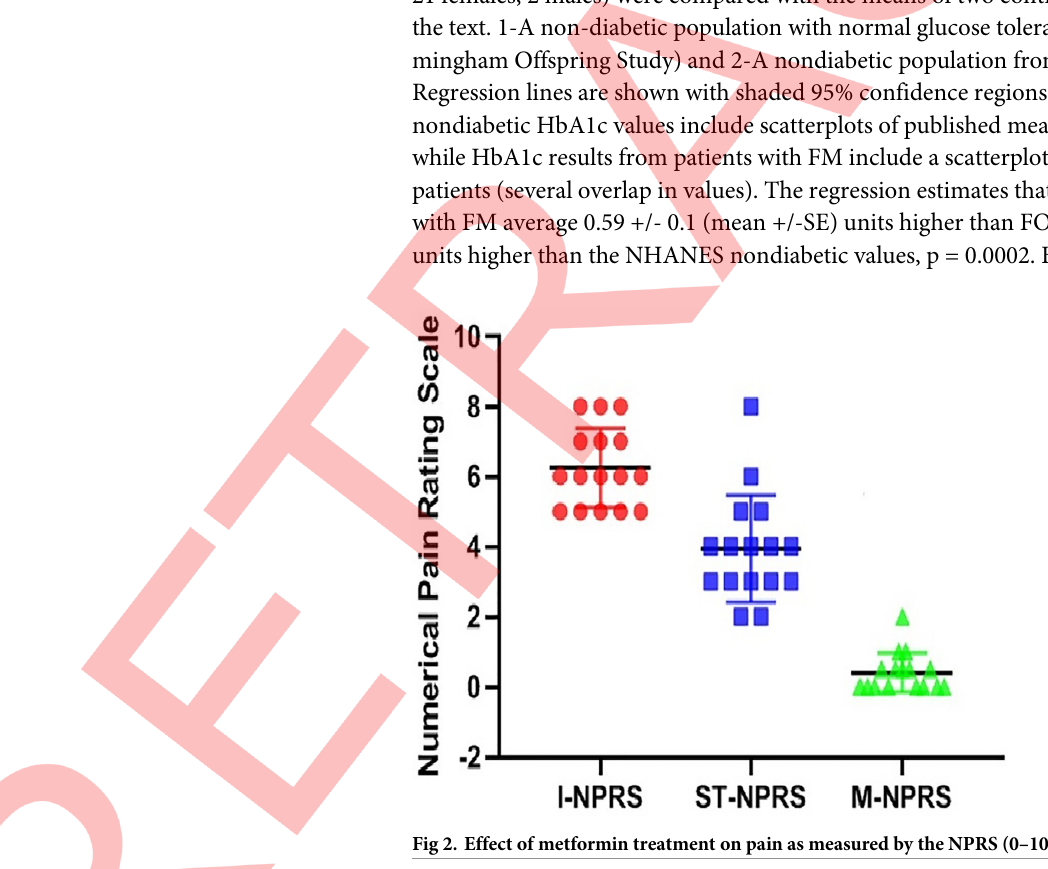
Fig 2. Effect of metformin treatment on pain as measured by the NPRS (0–10 scale).